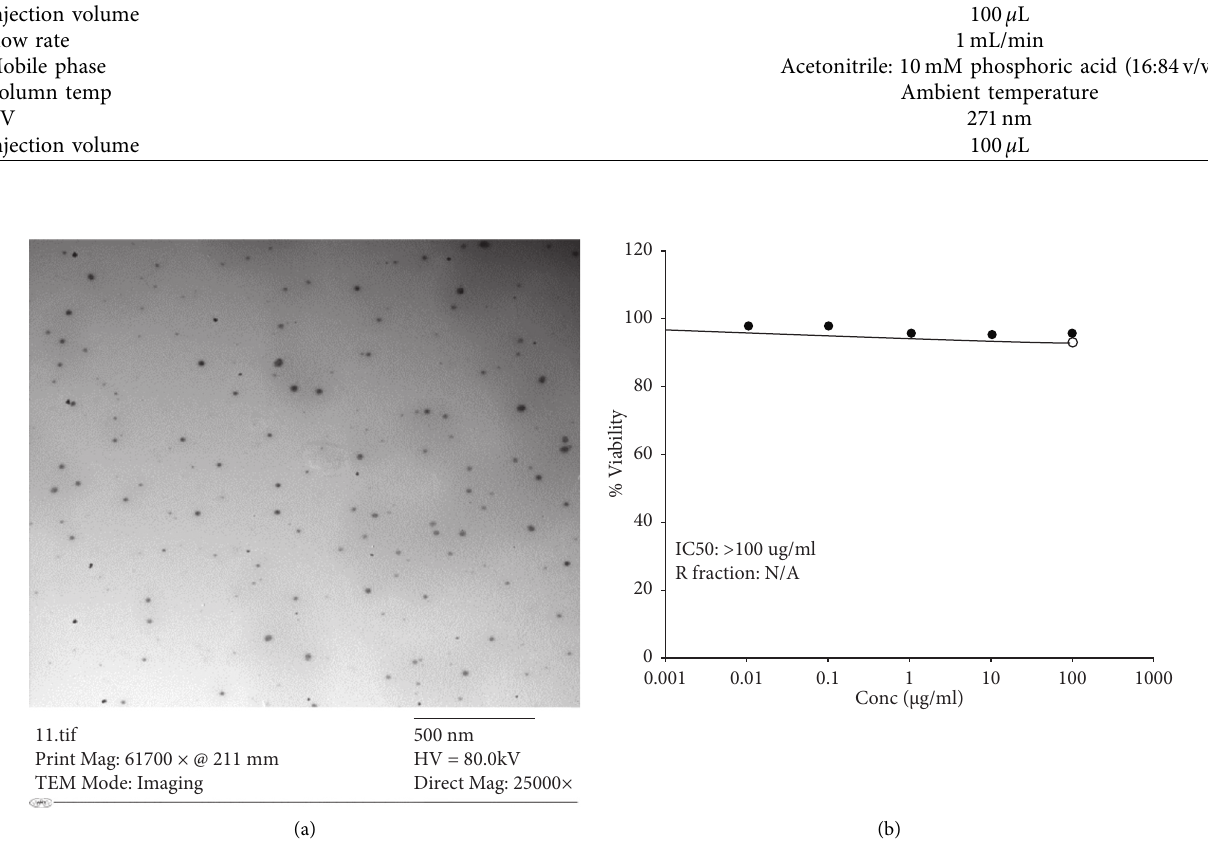
Figure 1: (a) TEM of thymol microemulsion. (b): Cell viability % of thymol microemulsion effect on Vero